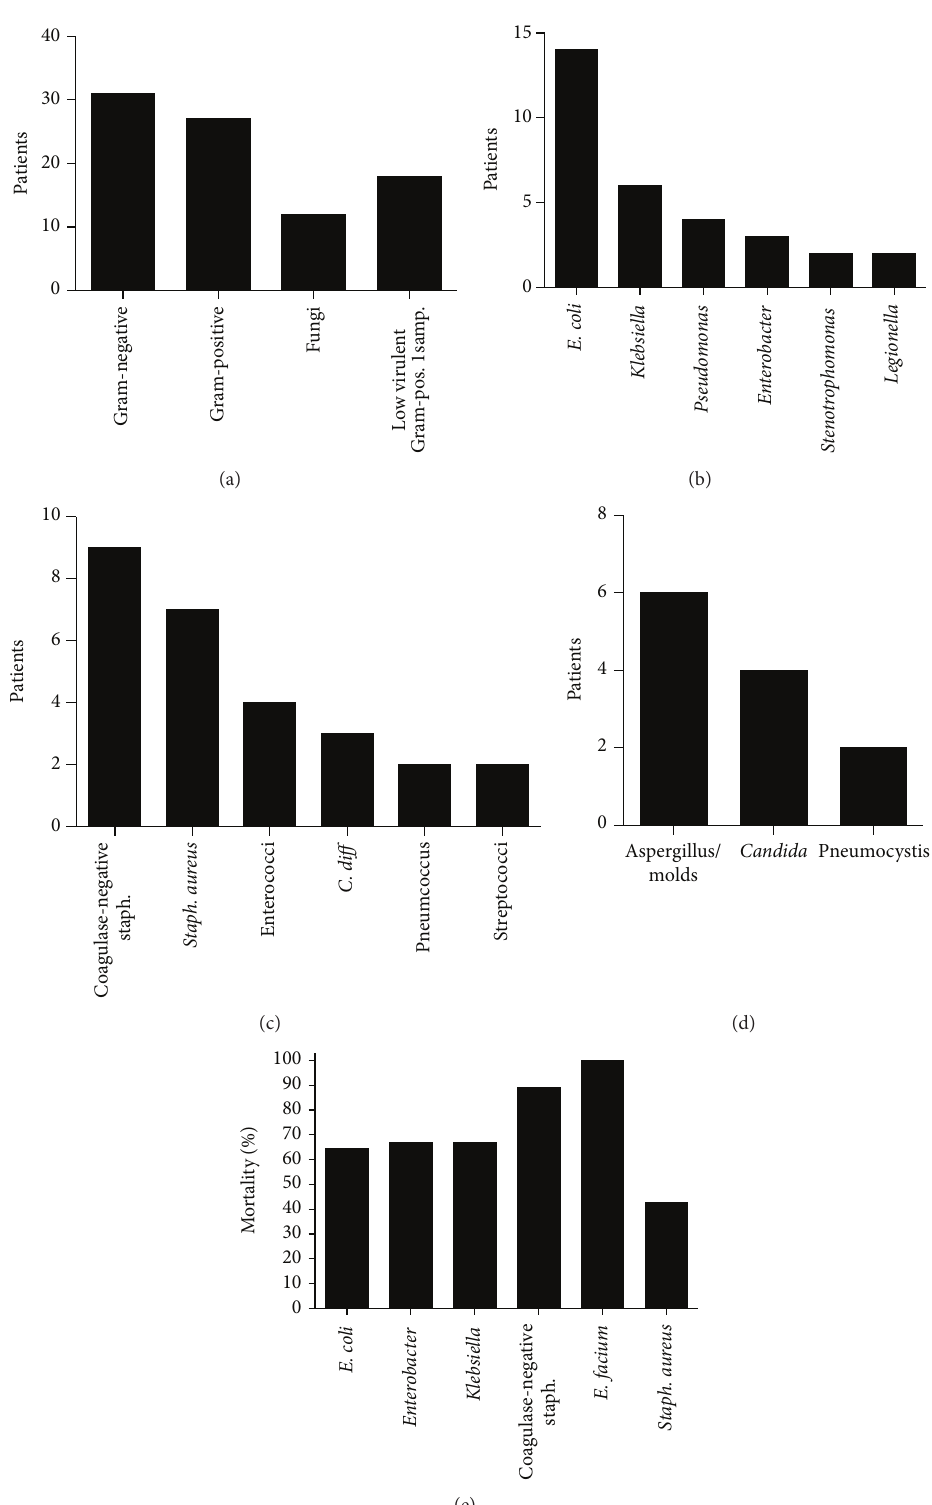
Figure 4: Microbiologic findings in the initial sepsis phase. (a) Overview of the pathogens identified in the initial sepsis. (b) The most commonly identified Gram-negative bacteria (displayed are the bacteria that were observed in at least 2 patients). (c) The most frequently found Gram-positive bacteria (displayed are the bacteria that were observed in at least 2 patients). (d) Fungi observed in the microbiologic diagnostic. (e) The mortality of the 6 most frequently found